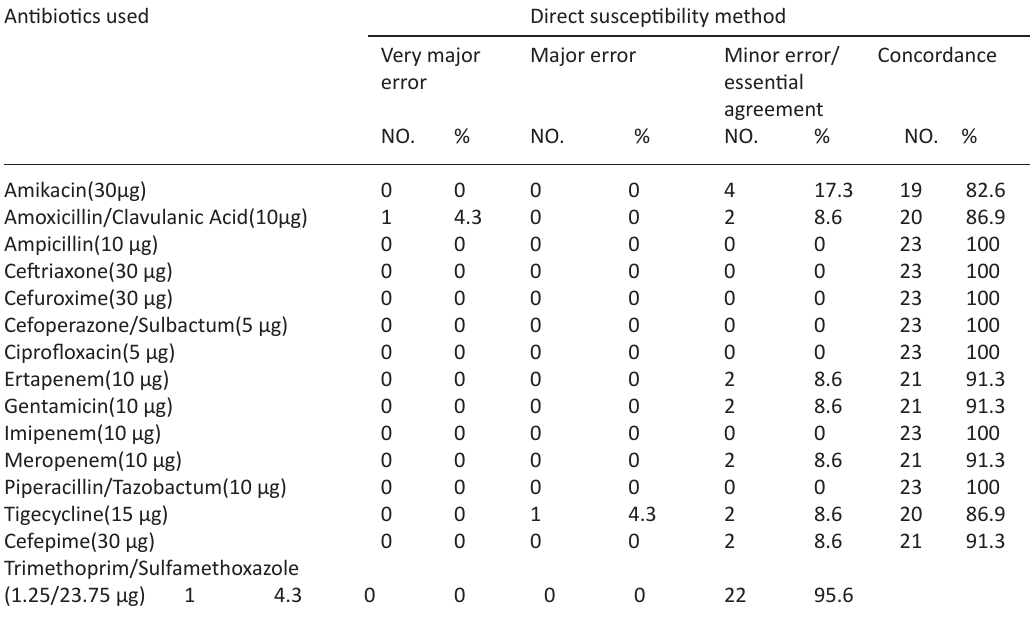
Table 5. Direct antibiotic susceptibility correlation for K.pneumoniae (n=23) Antibiotics used